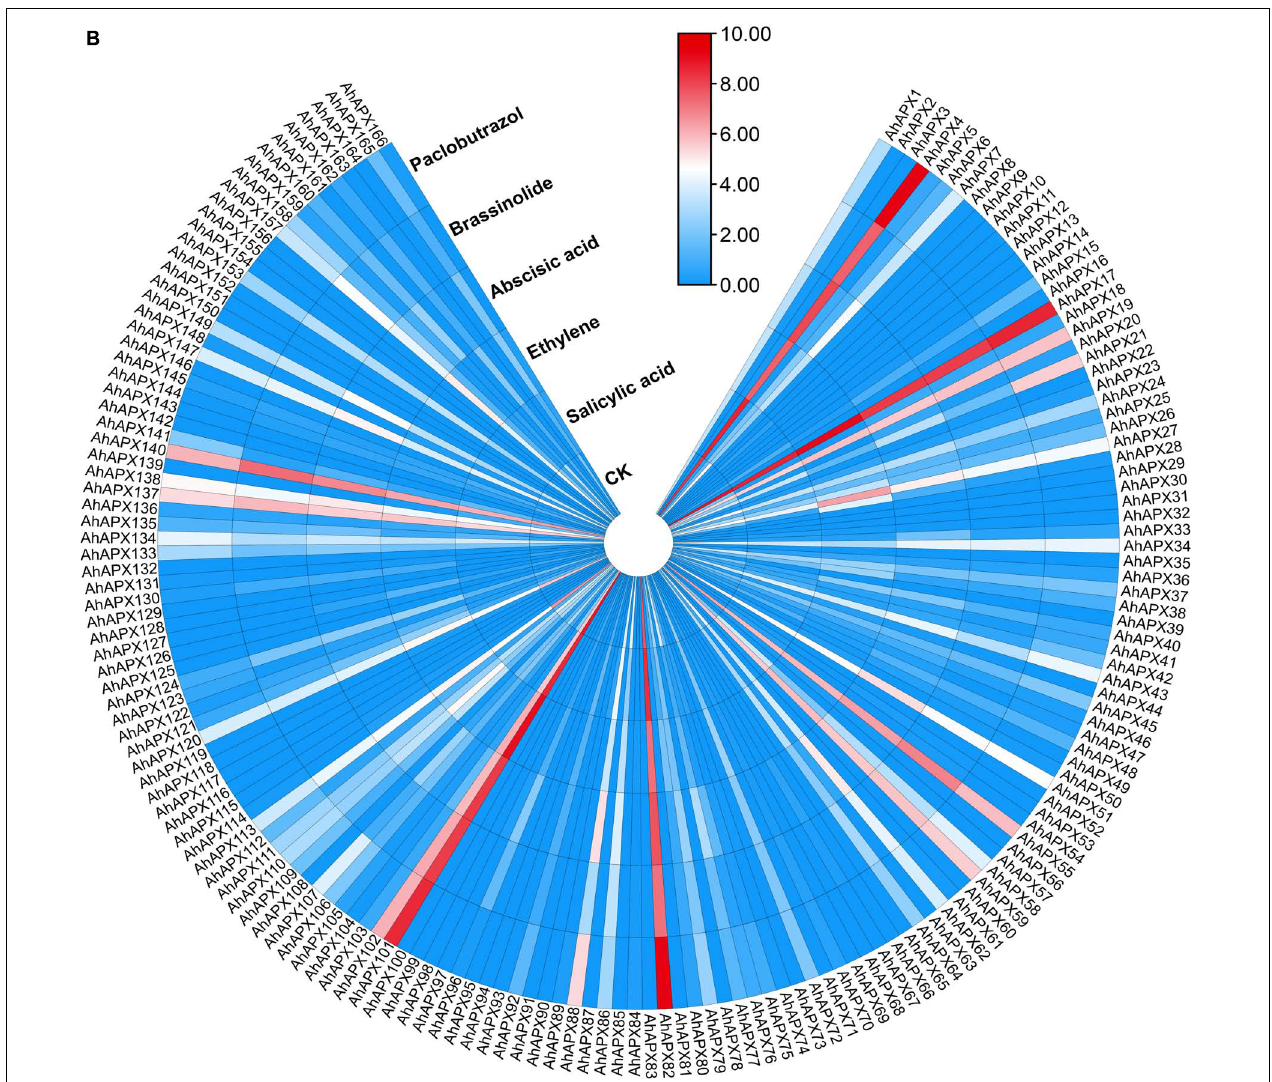
FIGURE 12 | Expression profiling of AhAPX genes under different (A) abiotic stress, including cold and drought stress, and (B) phytohormone treatments such as abscisic acid, salicylic acid, ethylene, brassinolide, and paclobutrazol. In both maps, the label “CK” refers to the control plants in comparison to the stress-treated plants. In the expression bar, the red, white and blue colors show high to low expression levels. The circular heat map was designed by taking log2 of fragments per kilobase of transcript per million (FPKM) values.